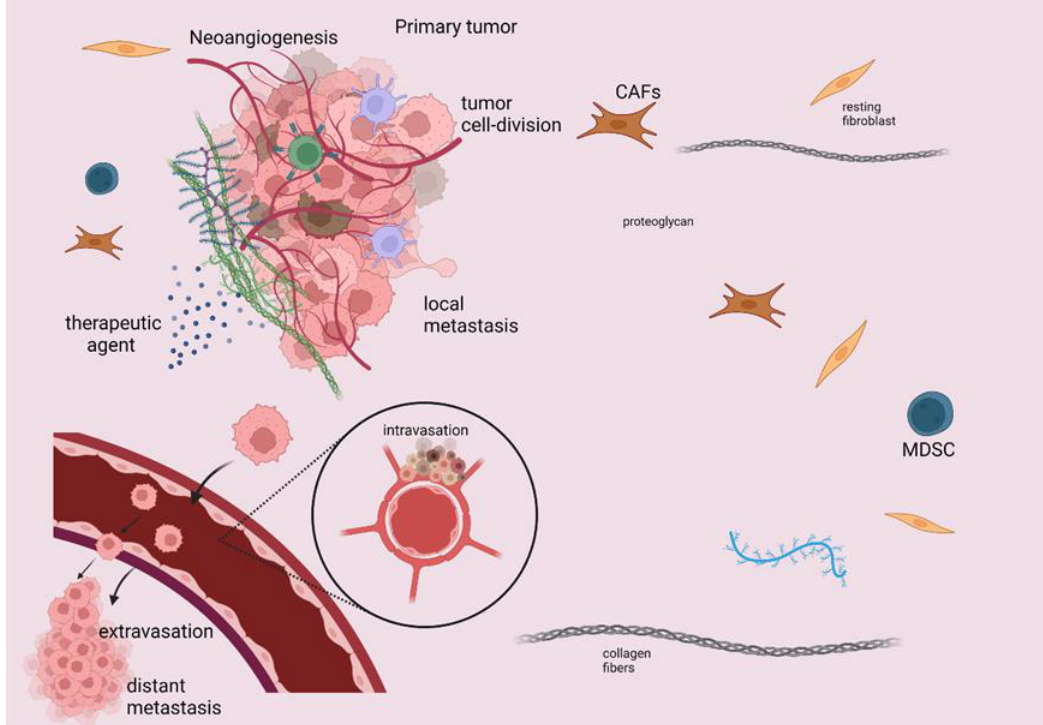
Figure 1. Schematic presentation of TME elements that induce immunosuppression, tumor progression, and metastasis. TME constitutes a surrounding stroma with a wide variety of cells, such as immune cells, fibroblasts, as well as many regulatory molecules, which are considered potential druggable targets. MDSC, B and T regulatory cells, TAMs, and cancer-associated fibroblasts (CAFs) have quite significant implications for cancer management, as they elicit an immunosuppressive effect that limits the efficacy of immunotherapeutic agents. TME immunosuppression is attributed to various molecules secreted by cancer cells, such as inhibitory checkpoints leading to the recruitment of immune cells, including MDSCs, T regulatory cells, and TAMs. This figure was created with BioRender.com, accessed on 14 May 2022 (agreement number UO23X0OEMQ).